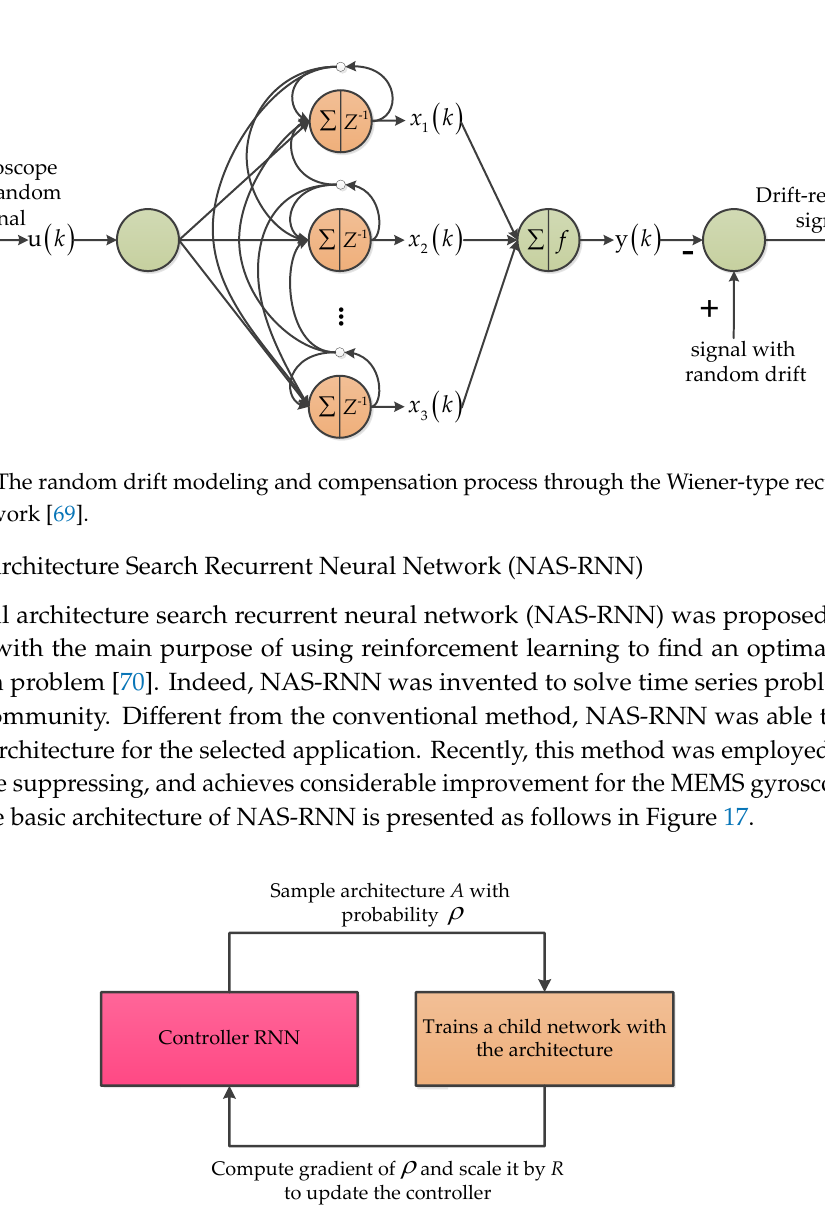
Figure 17. The basic architecture of neural architecture search recurrent neural network [70].